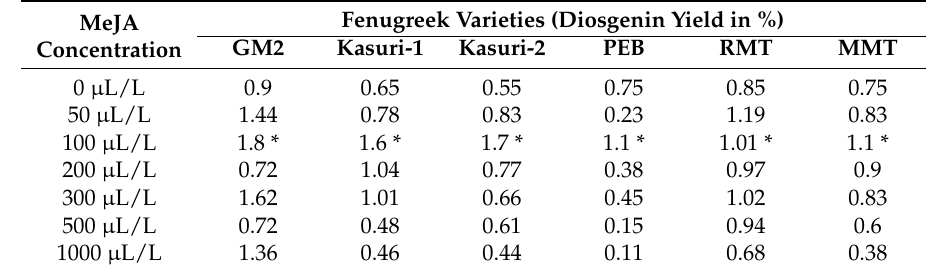
Table 2. Effect of methyl jasmonate (MeJA) treatments on diosgenin content (%) in fenugreek ( Trigonella foeum-graecum L.) varieties. MeJA Concentration